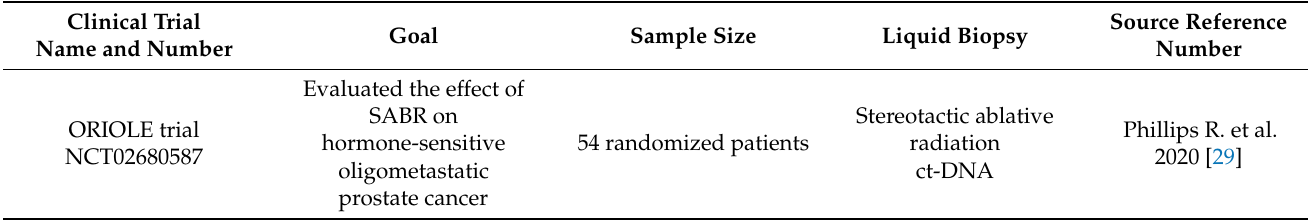
Table 2. Landscape clinical trial employing liquid biopsy in